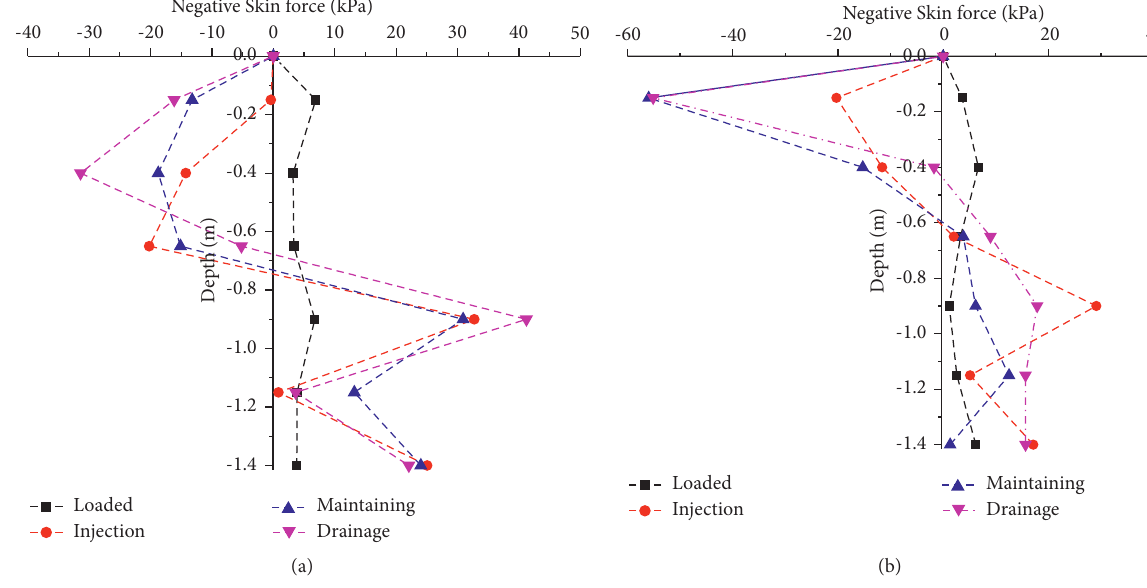
Figure 8: Typical negative skin force distribution of piles in different test conditions. (a) Pile load: 12kN. (b) Pile load: 24